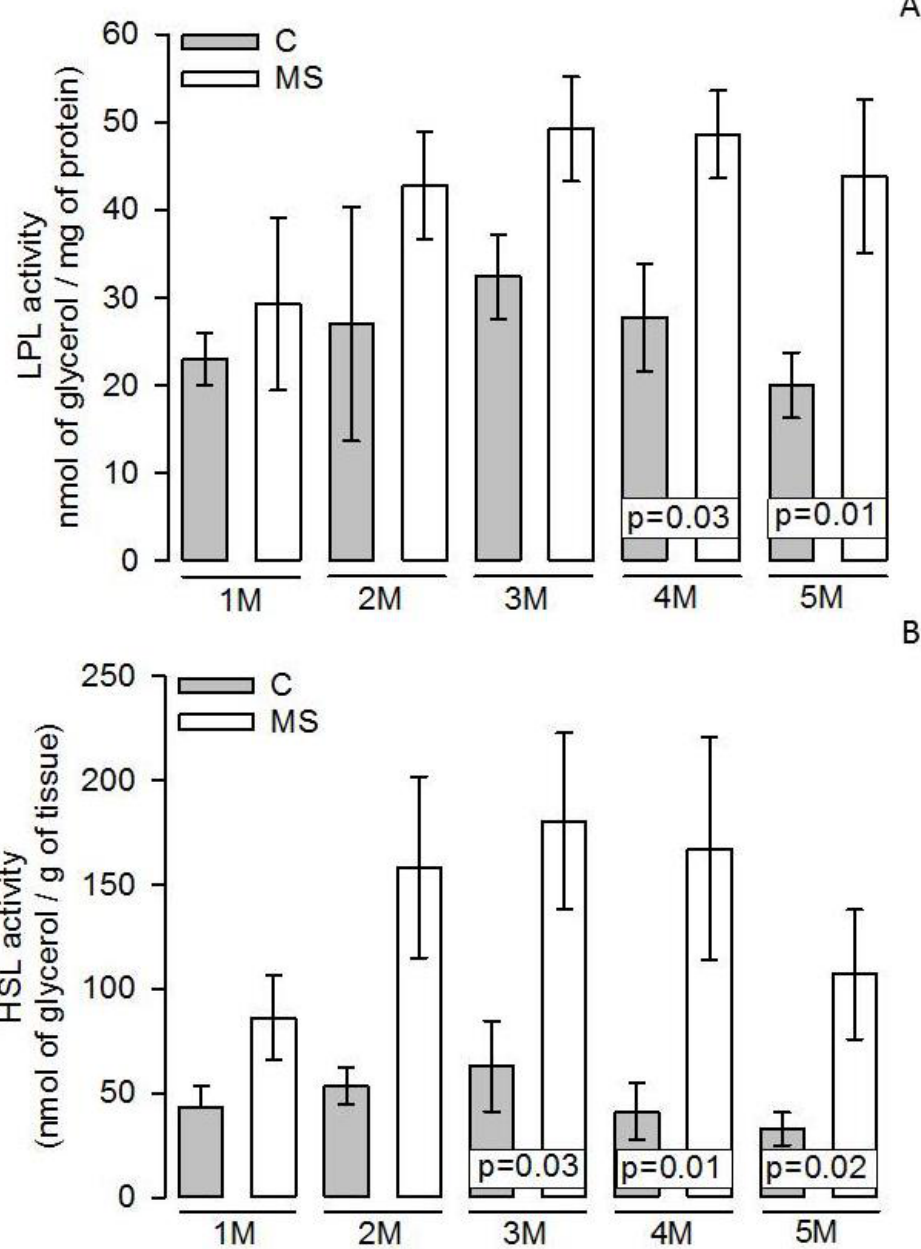
Figure 3. Effect of 30% chronic sucrose on the LPL ( A ) and HSL ( B ) activities through the five months of the treatment determined in the adipocyte homogenates in the experimental groups. Values are the mean ± SEM, n = 7 rats per experimental group. Abbreviations: C = Control; MS = Metabolic syndrome; LPL = Lipoprotein lipase; M = Month; HSL = Hormone sensitive lipase.